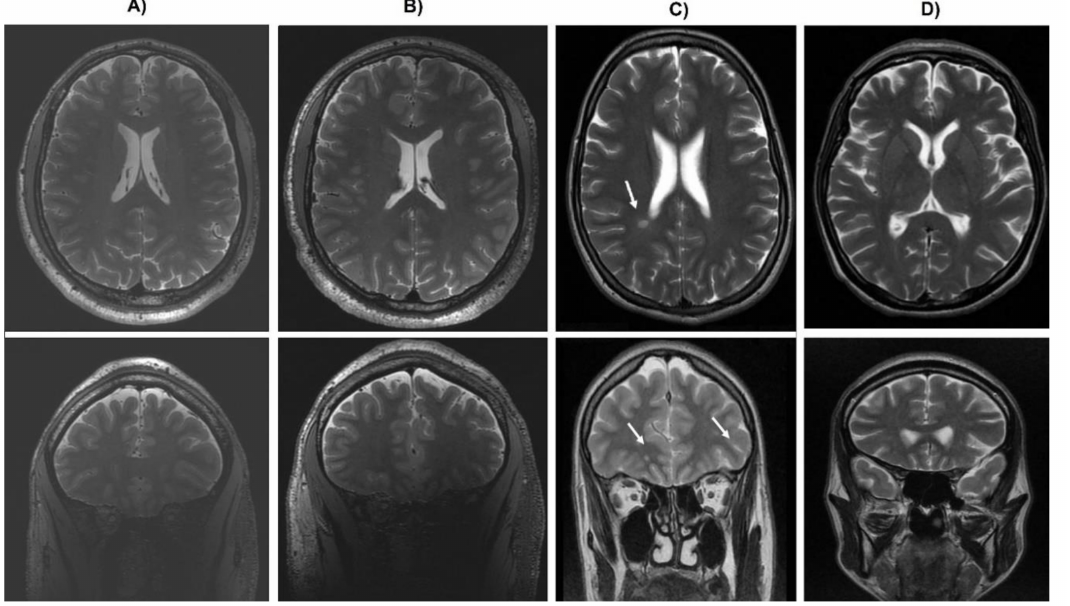
Figure 1. T2 Magnetic resonance images captured from ( A ) health participant (H), ( B ) participant with diagnosed schizophrenia (S), ( C ) patient with white matter hyperintensities (SN), ( D ) patient